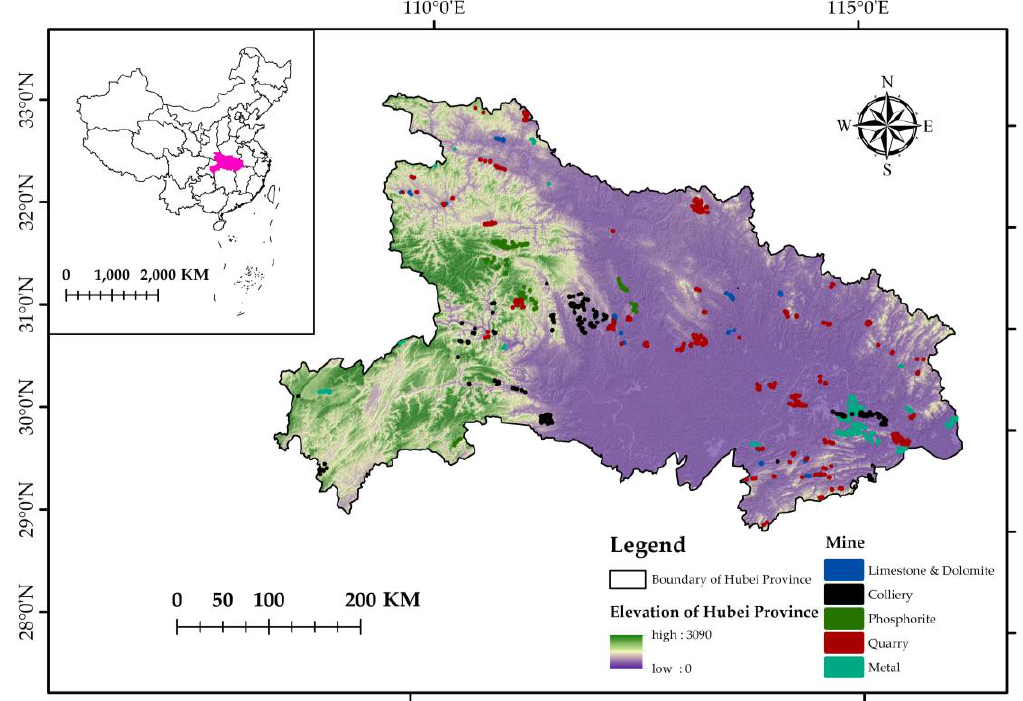
Figure 1. Landform and mine distribution map of Hubei Province.